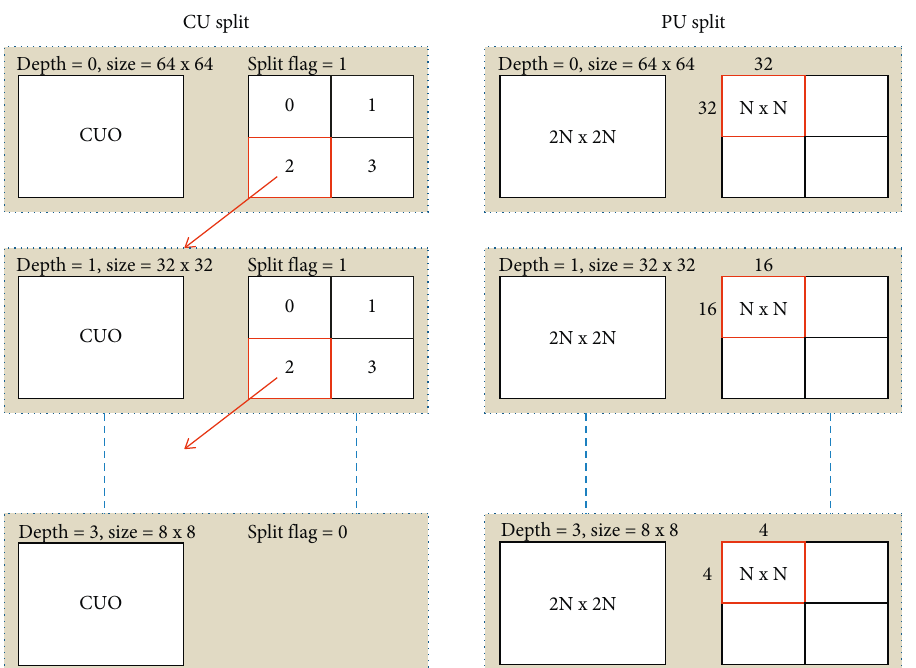
Figure 1: The architecture of the recursive split of the coding unit and the prediction